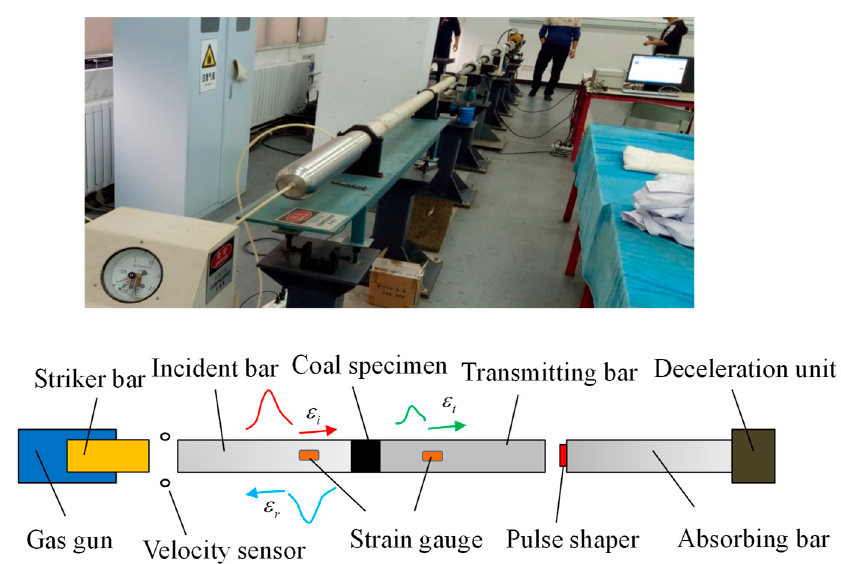
Figure 2. The apparatus and schematic diagram of a split Hopkinson pressure bar (SHPB) system.